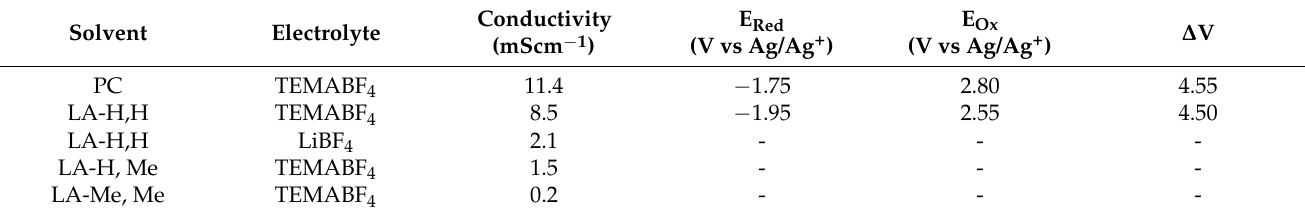
Table 2. Electrolyte